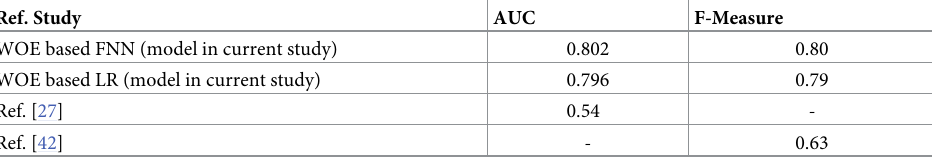
Table 9. Performance comparison between this study and previous studies in [27] and [42] using Dataset-1. Ref.